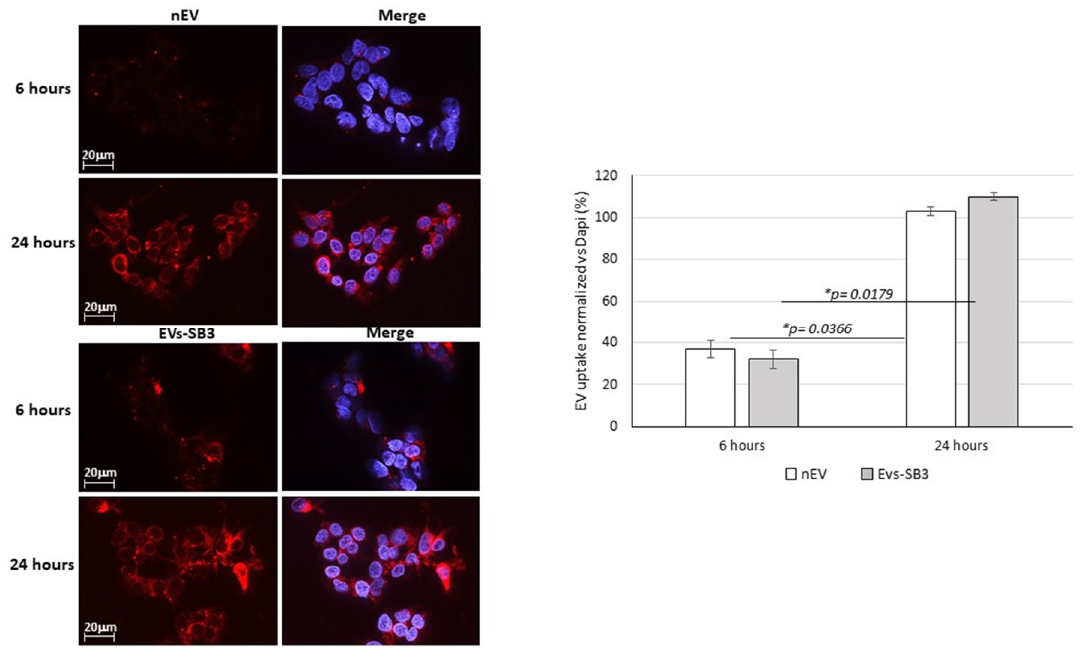
Figure 4. Left panel: Fluorescence expression of DIL-EVs uptake in HepG2 cells over a 6–24 h timeframe. Original magnification 63 × . Right panel: Graphic representation of DIL-EVs quantification in HepG2 cells. The negative controls were subtracted from the fluorescence intensity of nEVs and EVs-SB3 and final results were normalized against staining of the nuclei with Dapi. The experiment was performed in triplicate.